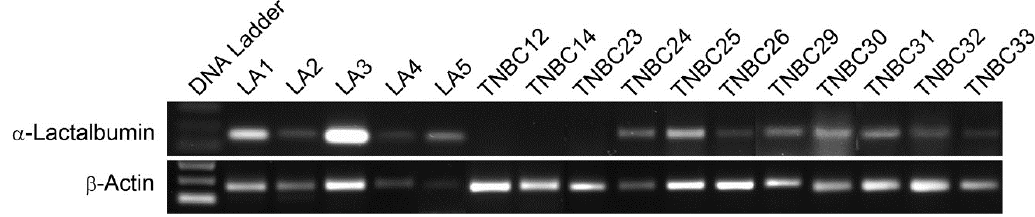
Figure 4. α-Lactalbumin Gene Expression in Human TNBC Tumors. RNA was extracted from 10 Figure 4. α -Lactalbumin Gene Expression in Human TNBC Tumors. RNA was extracted from 10 µ